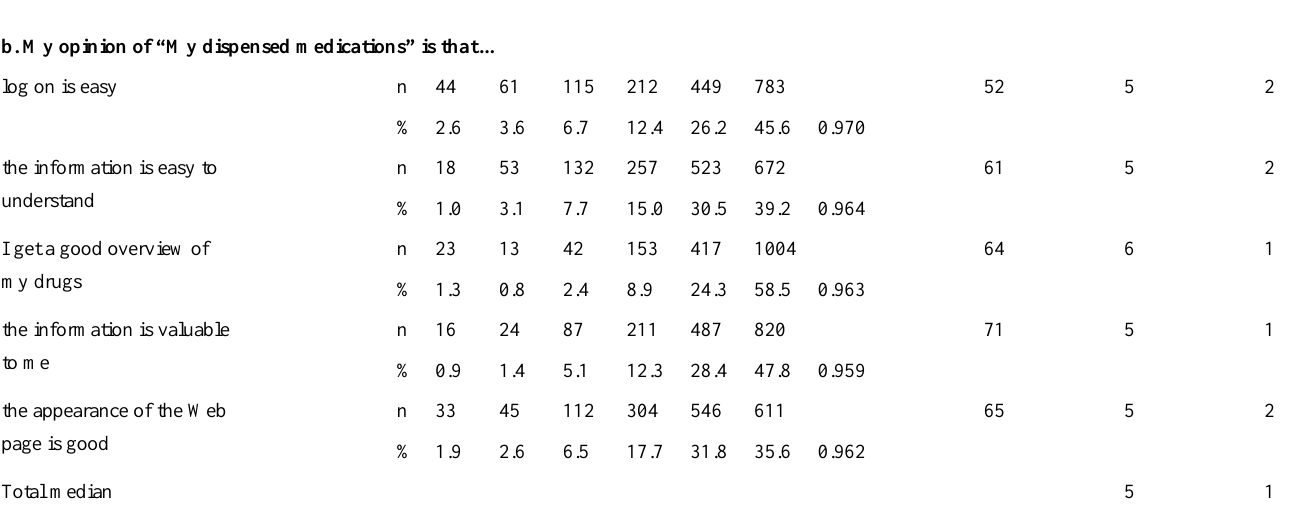
(Table 1). The high grades for the statements ( P -values